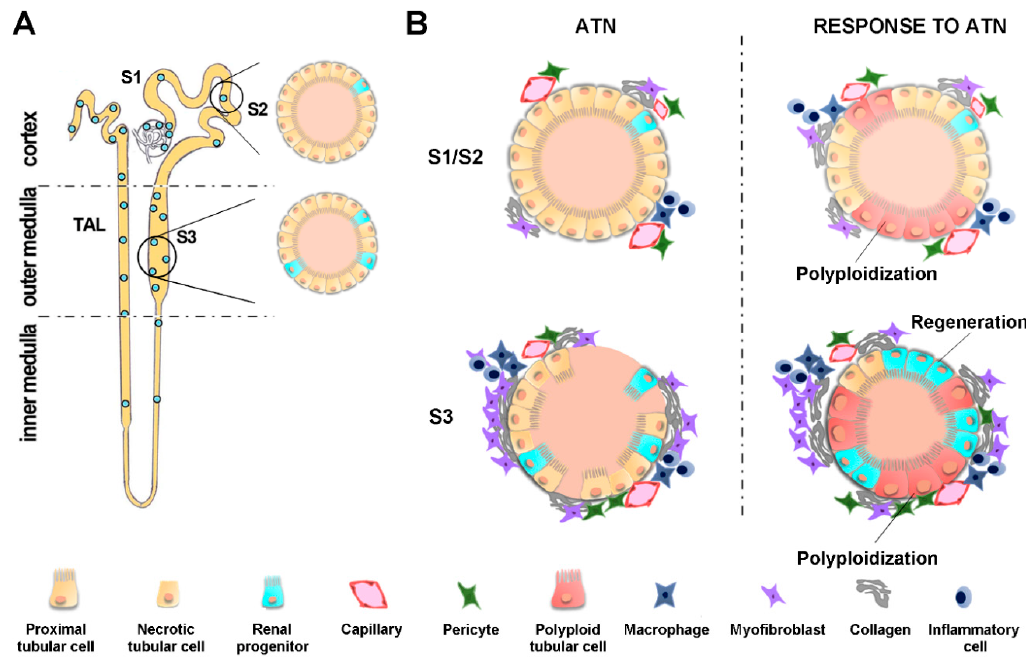
Figure 2. A new pathophysiological interpretation of tubular response to AKI leading towards CKD: The proliferation of renal progenitors and polyploidization of tubular cells. ( A ) Schematic localization of renal progenitors scattered along the S1–S2 segment, the S3 segment, and thick ascending limb (TAL) in the nephron. (Figure modified from Lazzeri et al., Trends Mol Med , 2019 ); ( B ) Top: In the uninjured proximal tubule S1–S2 segment, tubular epithelial cells enhance their working capacity by entering the cell cycle to increase their DNA content without division, resulting in polyploid tubular cells (i.e., polyploidization). Bottom: In the necrotic proximal tubule S3 segment, renal progenitors proliferate and complete cell division to drive regeneration, while the remnant tubular epithelial cells undergo polyploidization rather than mitosis. ATN: Acute tubular